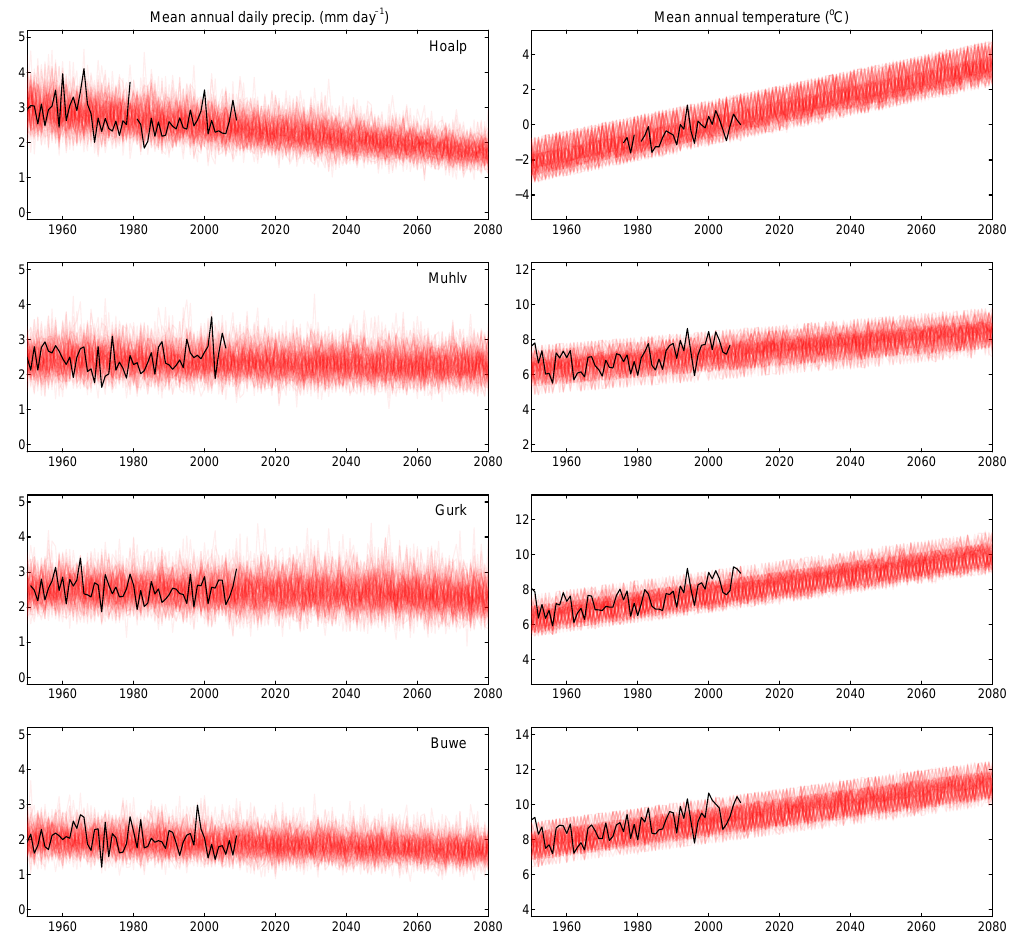
Figure 8. Stochastic simulations of mean annual precipitation and mean annual temperature (red lines) for St. Jakob Def (Hoalp), Pab- neukirchen (Muhlv), Klagenfurt (Gurk) and Wöerterberg (Buwe); 100 simulated time series for each station. For comparison, observations are shown (black